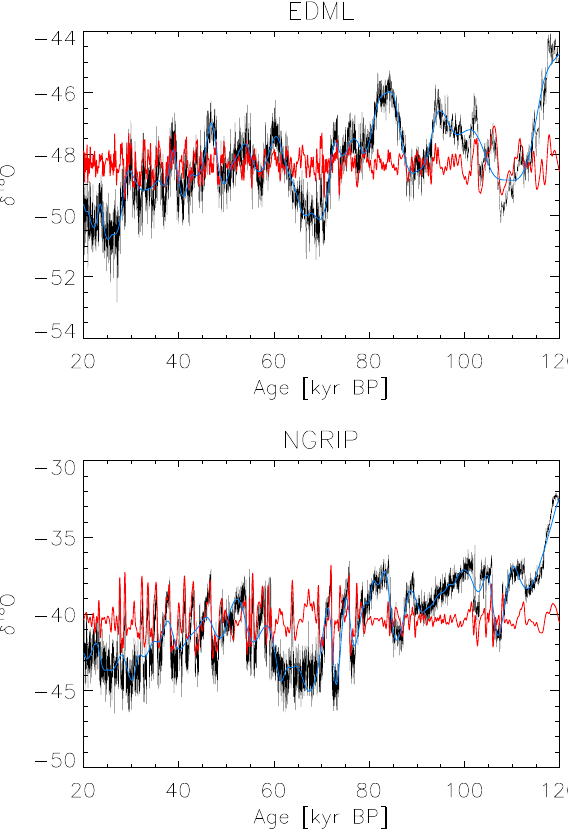
Figure 5. δ 18 O data (black lines), short timescale reconstructions N H (t) and S H (t) (red lines), and long timescale reconstructions N L (t) and S L (t) (blue lines) for the EDML (upper panel) and NGRIP (lower panel) datasets. An offset corresponding to the tem- poral mean of the δ 18 O original data was applied to the EMD re- constructions in order to allow visualization in the same plot.